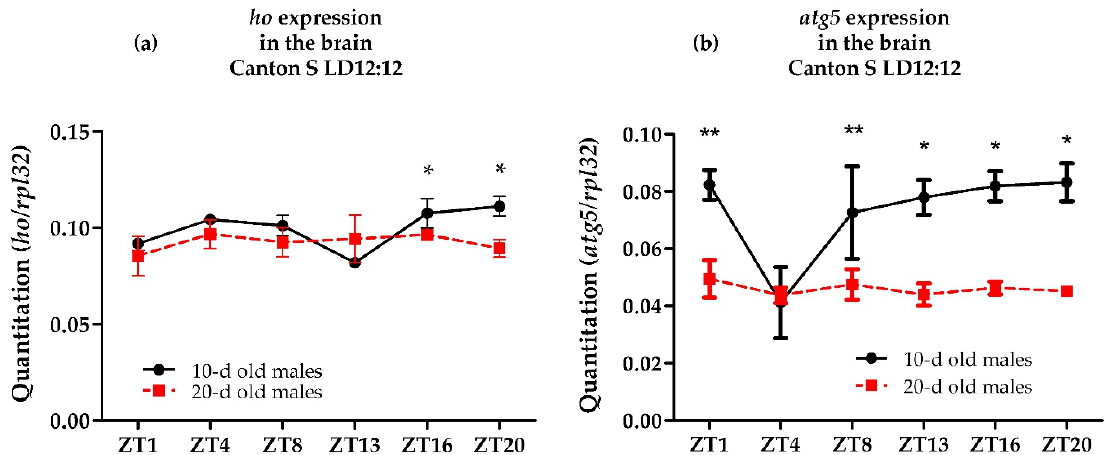
Figure 2. Effects of aging on the daily mRNA expression of heme oxygenase ( ho ) ( a ) and autophagy- related 5 ( atg5 ) ( b ) in the brain of adult male Drosophila melanogaster . Data shown as means ± SD. Statistically significant differences between groups are indicated with asterisks (10-d old males vs. 20-d old males: (*) p < 0.05 or (**) p < 0.01 at ZT16 and ZT20 for ho expression and ZT1, ZT8, ZT13, ZT16 and ZT20 for atg5 expression).